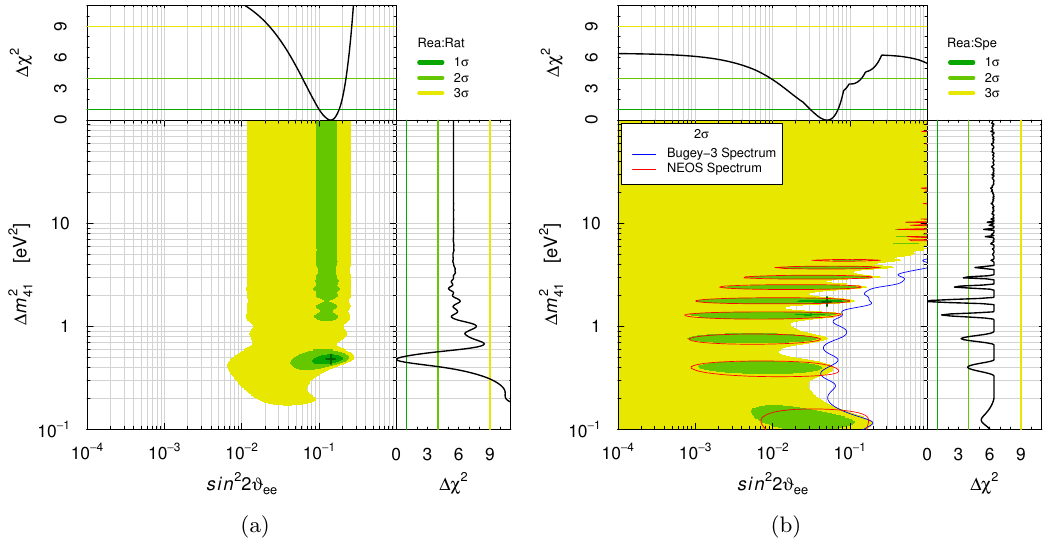
Figure 2 . Allowed regions in the sin 2 2 # ee {(cid:1) m 2 plane and marginal (cid:1) (cid:31) 2 ’s for sin 2 2 # ee and (cid:1) m 2 41 obtained from: (a) the combined (cid:12)t of the rates of the reactor neutrino experiments in table 1; (b) the combined (cid:12)t of the spectra of Bugey-3 [53] and NEOS [37] reactor antineutrino experiments; the best-(cid:12)t points corresponding to (cid:31) 2 in table 4 are indicated by crosses. min